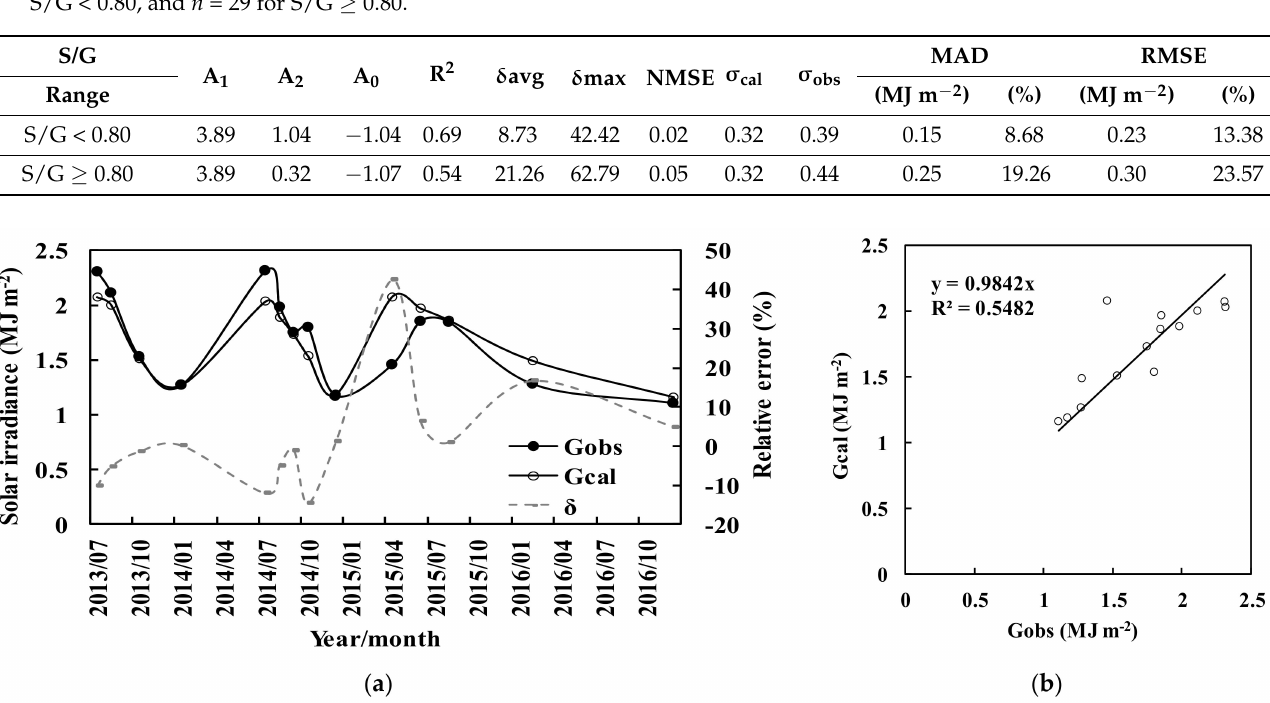
Figure 1. ( a ) Time series of monthly mean global horizontal solar irradiances: calculated solar irradiances (G cal , from the model Equation (3)), observed solar irradiances (G obs ), and their relative errors ( δ ) (S/G < 0.80). ( b ) Scatter plot of calculated versus observed solar irradiance (G cal vs. G obs ) (S/G < 0.80). The regression parameters in the legend were obtained for a fit forced through